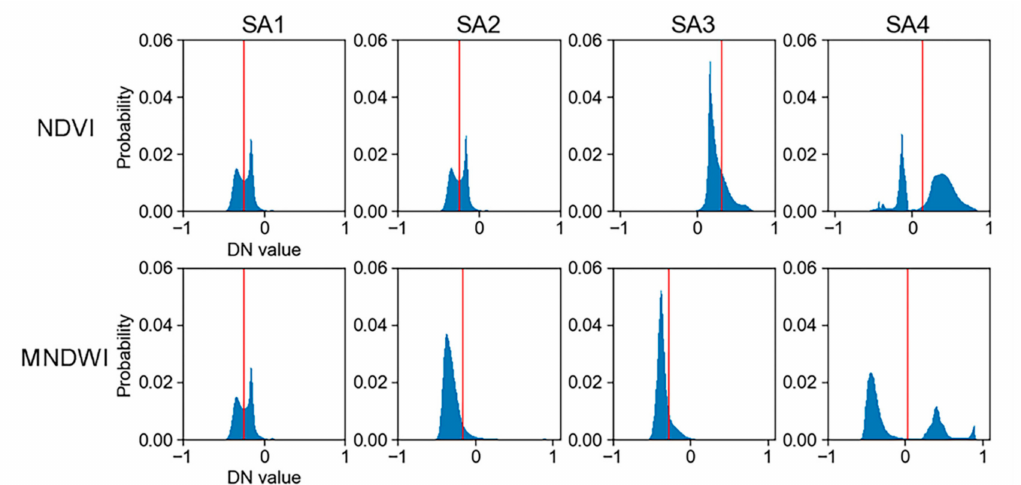
Figure 9. Histograms of frequency distributions of vegetation and water body indices in the four study areas. The red lines indicate the optimal threshold position of the vegetation and water masks automatically acquired by the Otsu